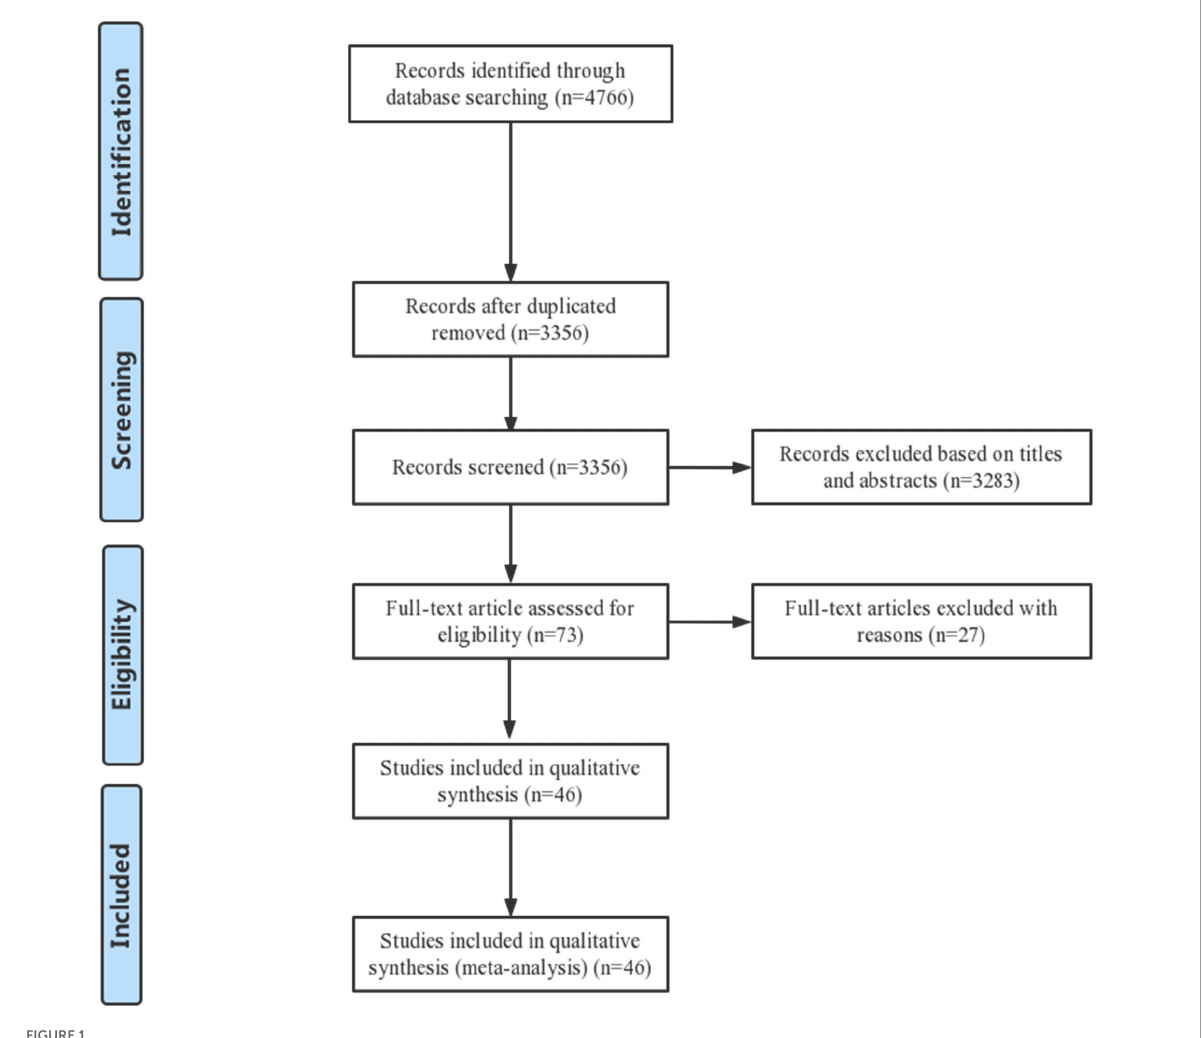
FIGURE1 Flow diagram of included/excluded